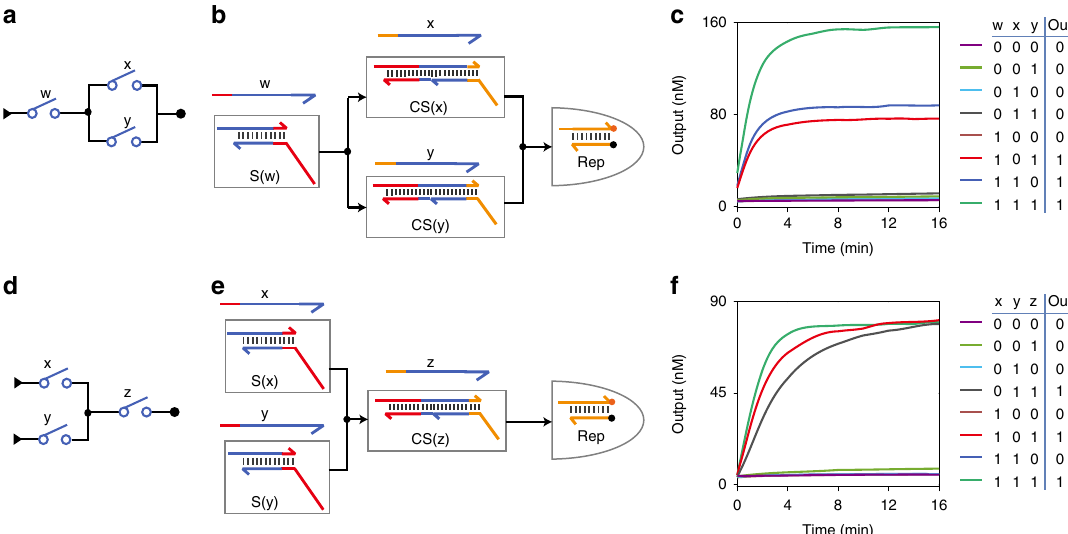
Fig. 3 Fan-out and fan-in of DNA switches. a – c Switching circuit diagram ( a ), molecular implementation ( b ), and fl uorescence readout ( c ) of a circuit with a two-output switch. d – f Switching circuit diagram ( d ), molecular implementation ( e ), and fl uorescence readout ( f ) of a circuit with a two-input switch. Source data are provided as a Source Data fi